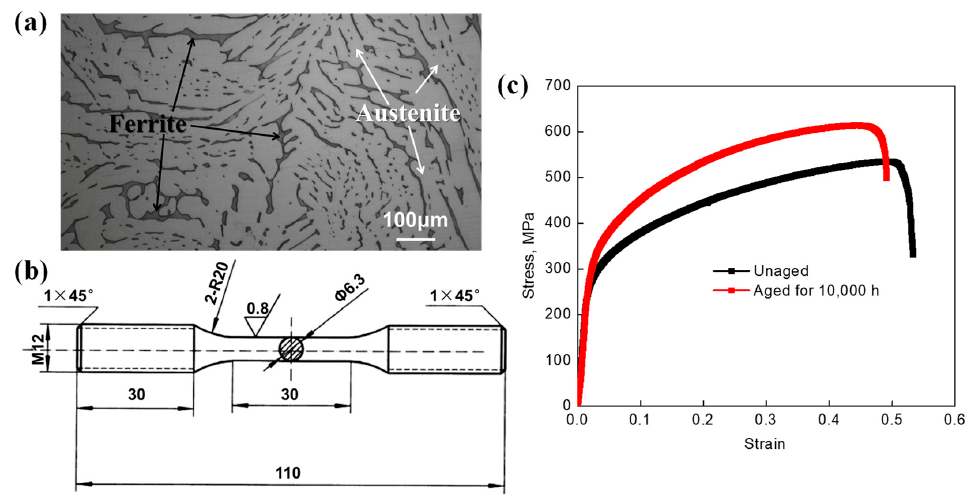
Figure 1. ( a ) Microstructure of the studied steel. ( b ) Geometry of the fatigue specimen (unit: mm). ( c ) Engineering stress-strain curves of the unaged and aged (400 °C, 10,000 h) CDSS.